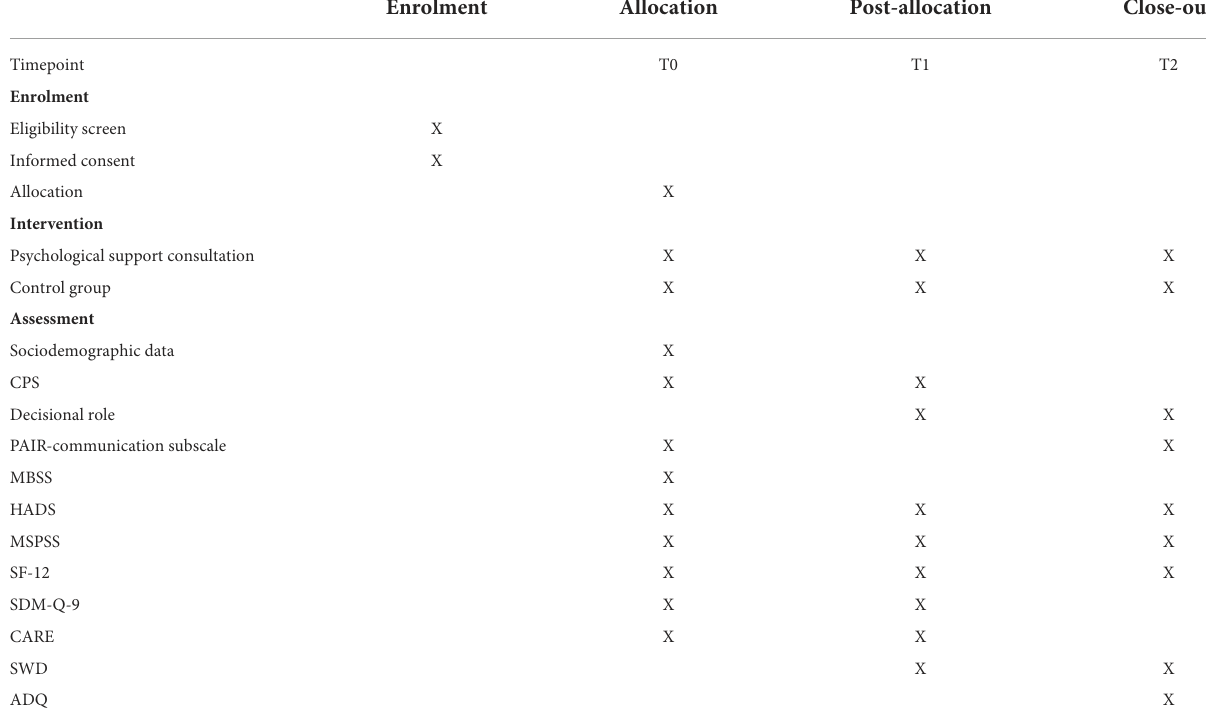
TABLE 1 Schedule of enrolment, intervention, and assessment.